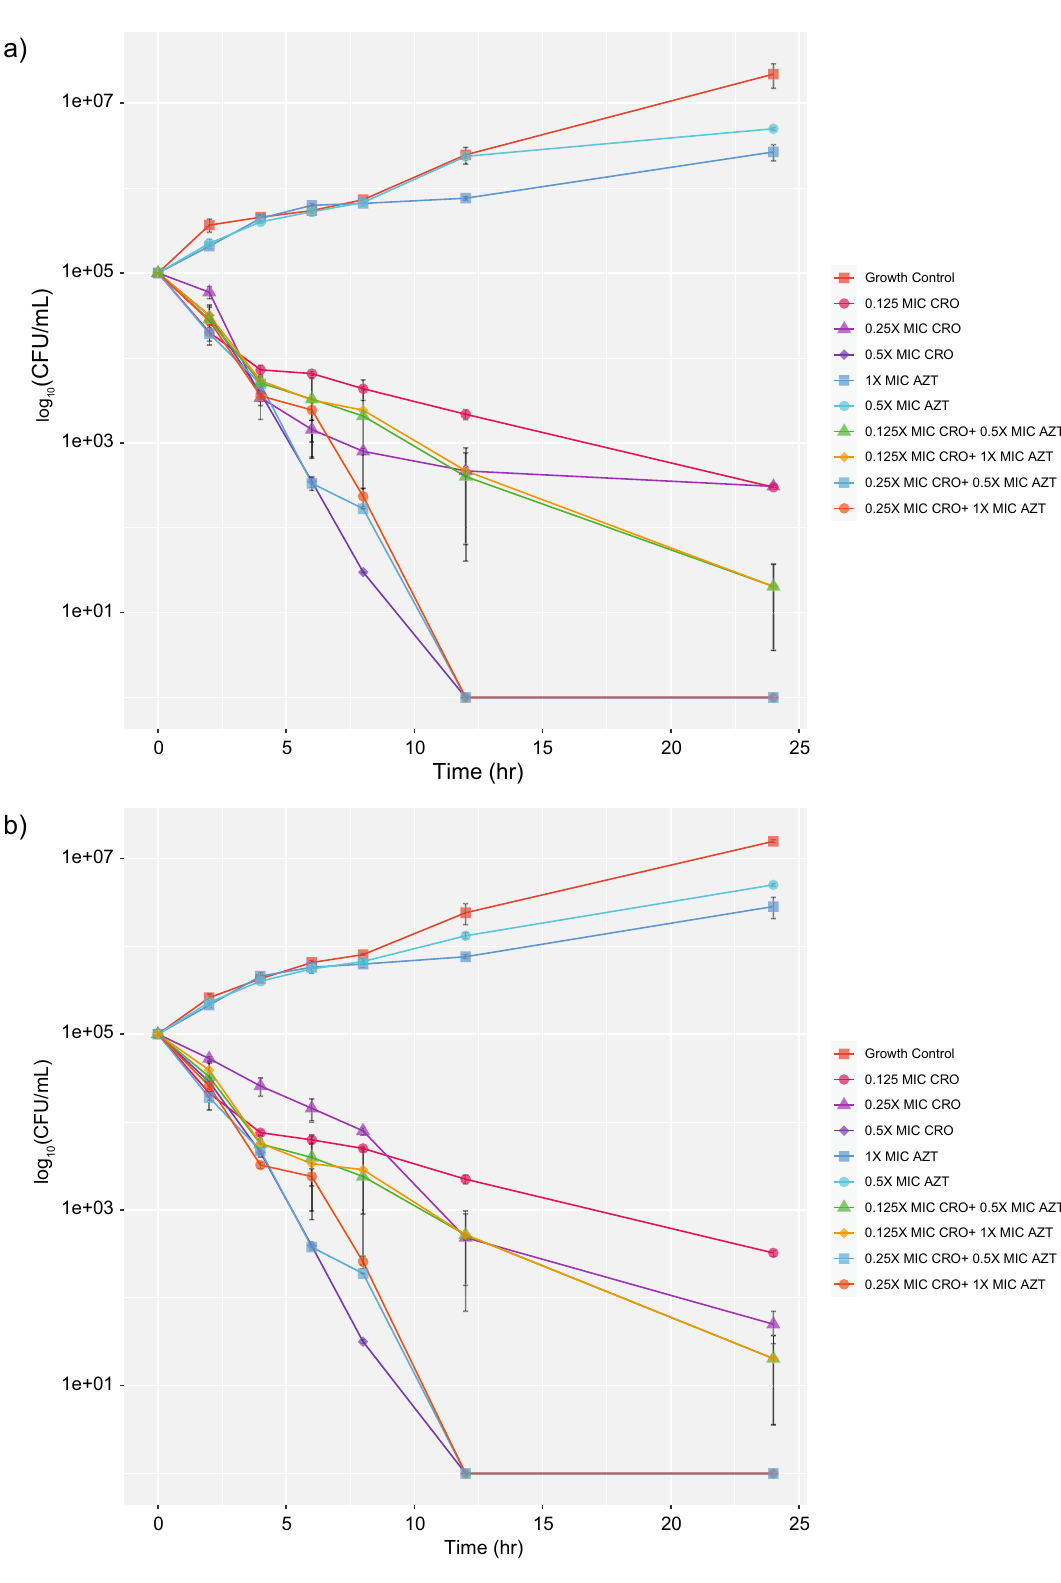
Figure 5. Time-kill curve of ceftriaxone plus azithromycin against N. gonorrhoeae isolates with reduced susceptibility to ceftriaxone ( a ) NG-083 and ( b )